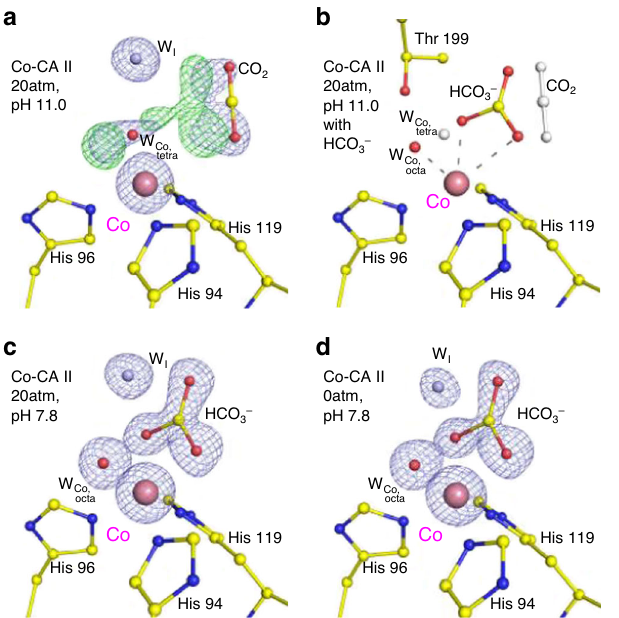
Fig. 5 Substrate/product binding in Ni- and Cu-CA II. The intermediate water (W I ) is colored in steel blue for clarity. The electron density (2F o – F c , blue) is contoured at 2.2 σ . a At 20 atm of CO 2 pressure, Ni-CA II maintains octahedral coordination with HCO 3 − binding. b Compared to the W Zn geometry in Zn-CA II (Fig. 3d), the nucleophilic attack geometry around W Ni ′ has steric hindrance on CO 2 molecule (adapted from Zn-CA II, 20 atm, white) and is distorted away. Distance between the position (2) and C atom of CO 2 is 1.55 Å. c Cu-CA II shows only disordered electron density in the CO 2 /HCO 3 − binding site. d The nucleophilic attack geometry around W Cu has steric hindrance on CO 2 molecule (adapted from Zn-CA II, 20 atm) and is signi fi cantly distorted away. Distance between the position (2) and C atom of CO 2 is 2.93